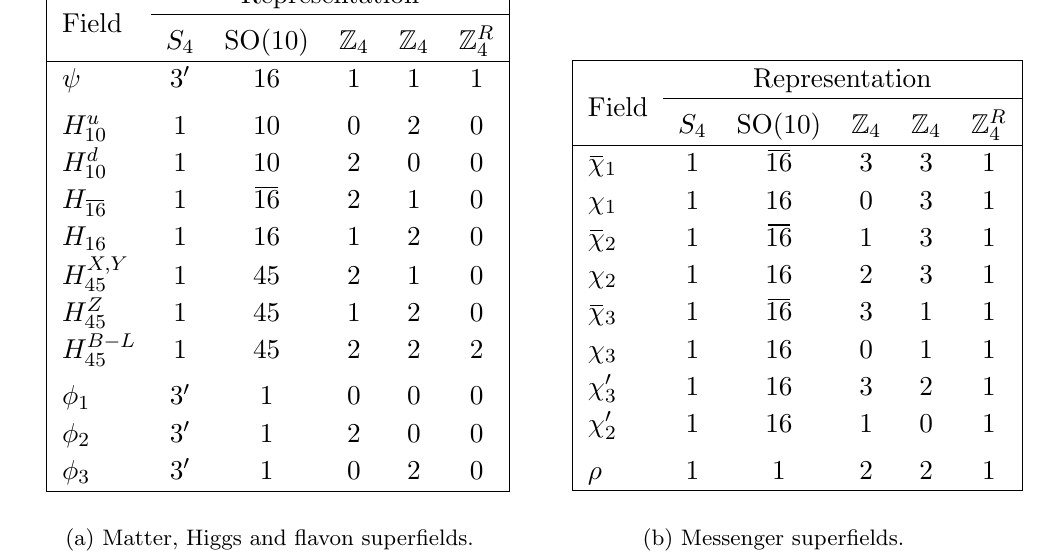
Table 1 . Field content giving the Yukawa superpotential in eq.